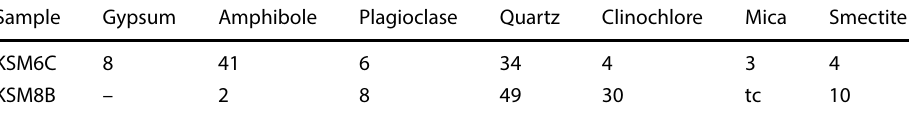
Table 1 XRD analysis of two Musina mine tailings, mineral contents expressed in